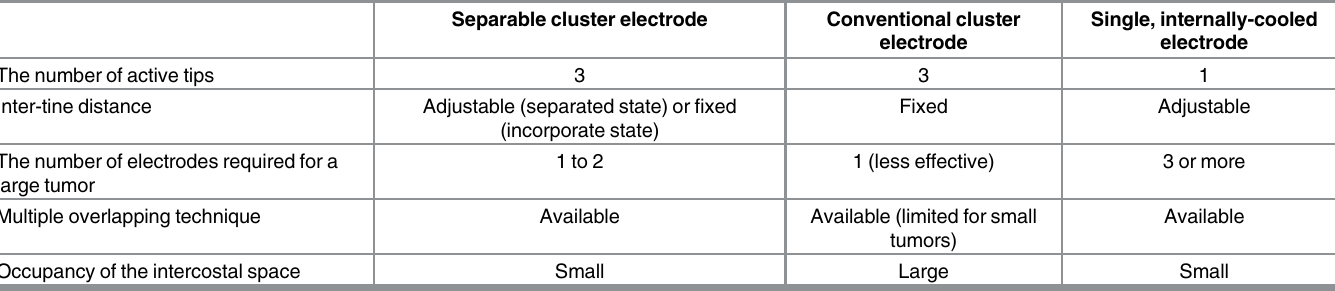
Table 2. Differences between separable cluster electrodes and other